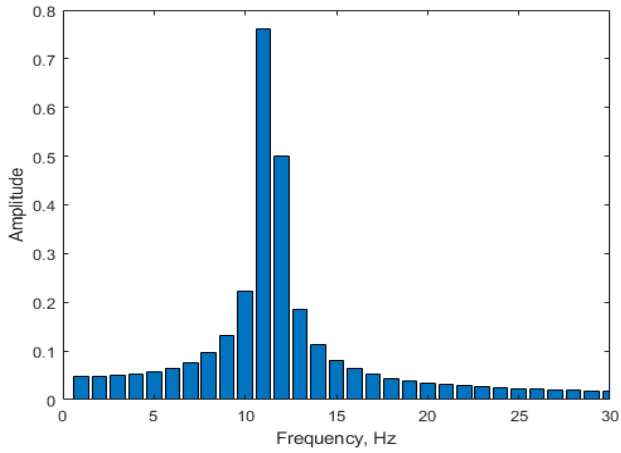
Figure 1. Illustration of the spreading spectrum of the DFT.